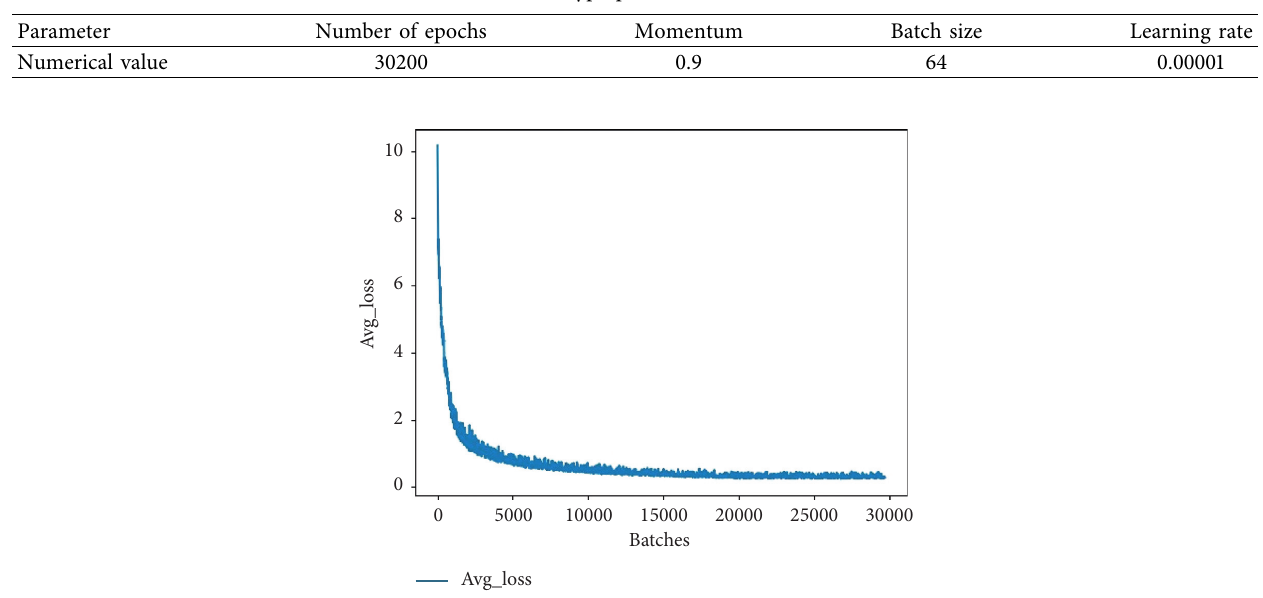
Figure 9: The average loss function of training.